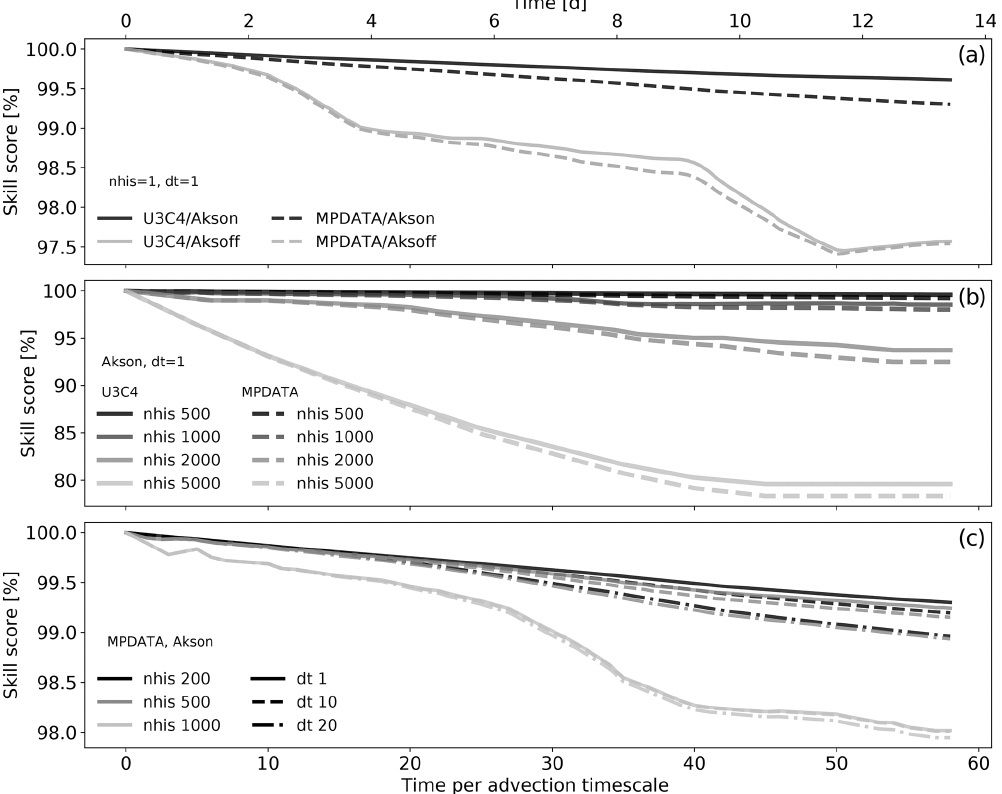
Figure 4. Skill scores for several subsets of offline simulations. (a) Performance between the MPDATA and U3C4 tracer advection schemes and whether the vertical salinity diffusion coefficient Aks is forced with the online simulation (“on”) or a constant background number (“off”). These cases also have nhis =1 (the online output was saved each time step) and dt =1 (the offline time step matched the online time step). (b) Performance between the MPDATA and U3C4 advection schemes with nhis values varying. These cases also have Aks forced from the online case and dt =1. (c) Performance for varying nhis and dt parameters, where MPDATA is used and Aks is forced from the online case. All offline simulations here are forced by his